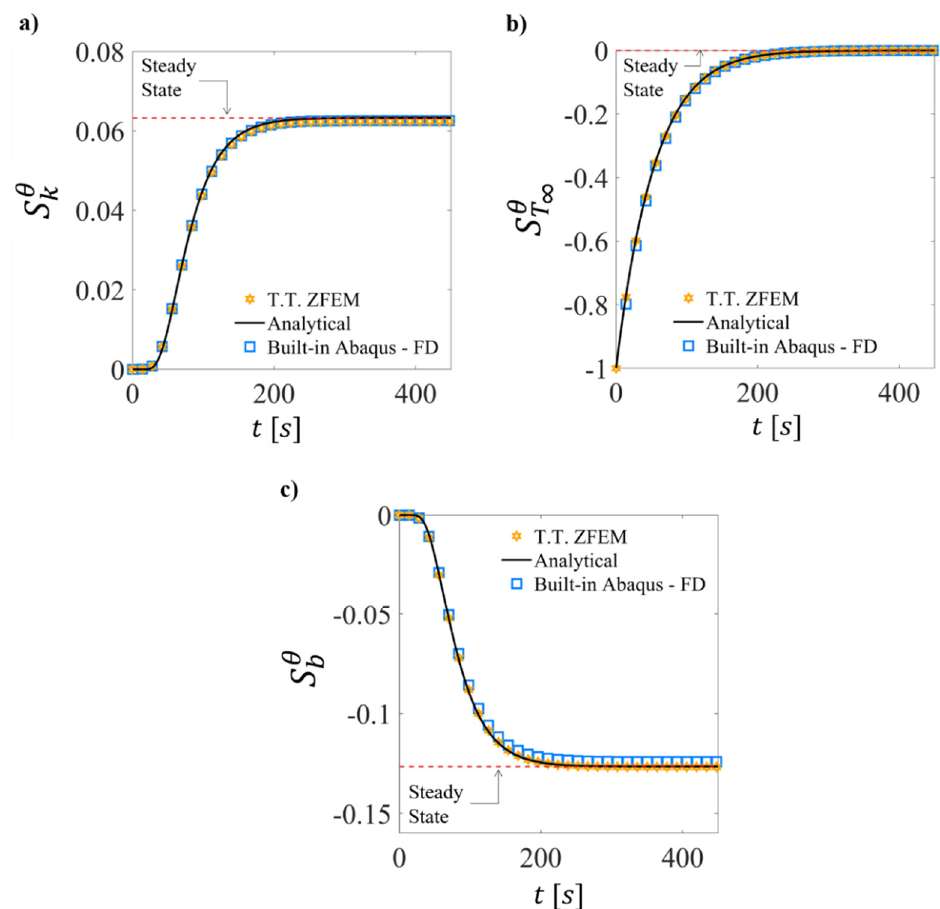
Figure 6. Dimensionless temperature sensitivity history at the fin tip to ( a ) thermal conductivity; ( b ) room temperature; ( c ) fin length. Solid black line, analytical sensitivity using analytical differentiation in Equation (23), yellow star, sensitivity using Transient Thermal ZFEM, blue square, sensitivity using 1% FD and Abaqus built-in element solutions, thin red dashed line, sensitivity using analytical differentiation for steady-state using Equation (24). Table 2. NRMSE of θ and the selected sensitivities compared to the analytical solution.